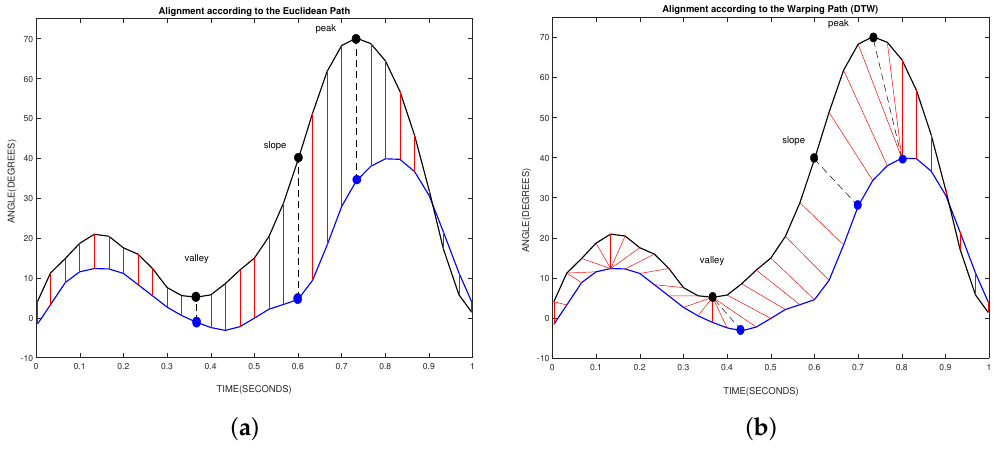
Figure 5. The alignment performed by the Euclidean and DTW algorithms. The movement belongs to the knee flexion/extension shown in Figure 4. The Vicon signal is shown in black line and the Kinect signal in blue line. The straight red lines indicate how the points are linked. There are three highlighted points: the peak, slope and valley from Vicon signal and the corresponding points in the Kinect signal. ( a ) The alignment of signals according to the Euclidean comparison. ( b ) The alignment of signals according to the DTW